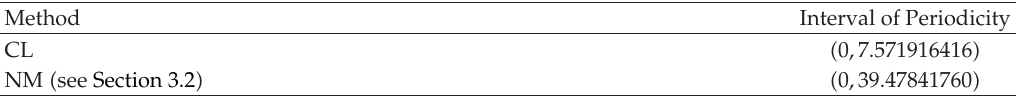
Table 1: Comparative stability analysis for the methods mentioned in Section